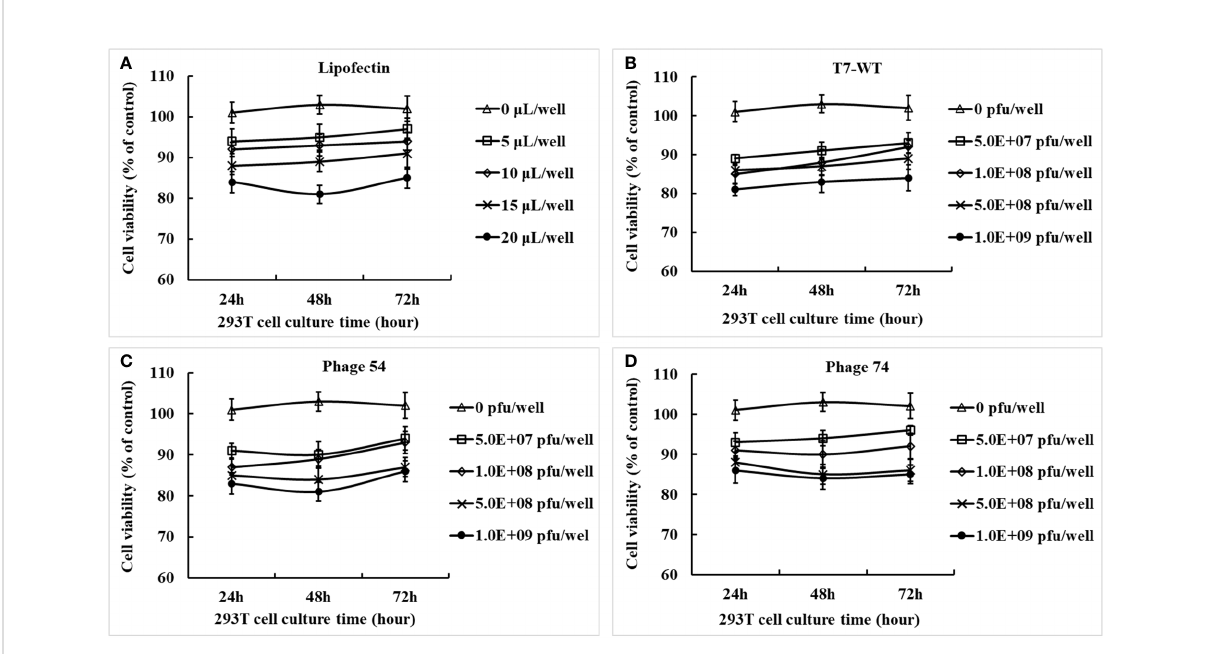
FIGURE 3 Cytotoxicity effects of Lipofectin and puri fi ed phage particles at different concentrations on HEK293T cells. (A) Lipofectin. (B) T7-WT particles. (C) Phage 54 particles. (D) Phage 74 particles. The in vitro cytotoxicity assay of Lipofectin and puri fi ed particles was measured by the cell counting kit-8 (CCK-8) method and is indicated as the percentage of viable cells. The values are represented as mean ± S.D. (n =